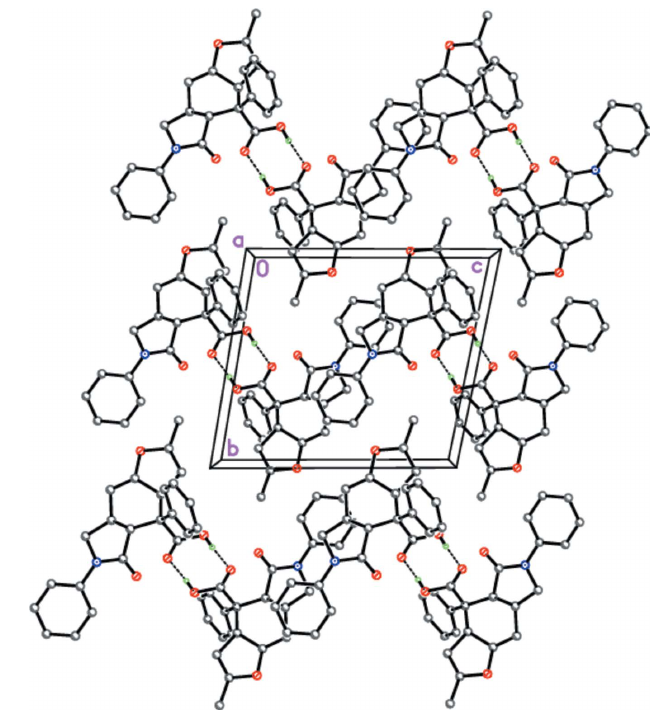
Figure 5 The hydrogen-bonded zigzag chains along the b- axis direction in I . Dashed lines indicate the intermolecular O—H (cid:3)(cid:3)(cid:3) O hydrogen bonds.